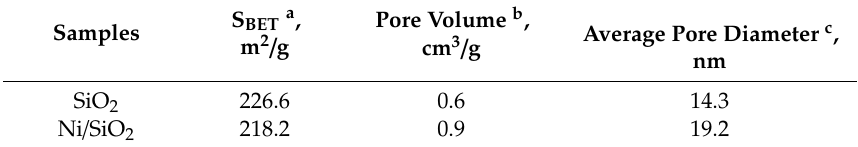
Figure 1. ( a ) N 2 adsorption–desorption isotherms and ( b ) pore distribution curves of SiO 2 and Ni / SiO 2 . Table 1. Textural properties of the support and Table 2. Composition and particle size of the catalyst.